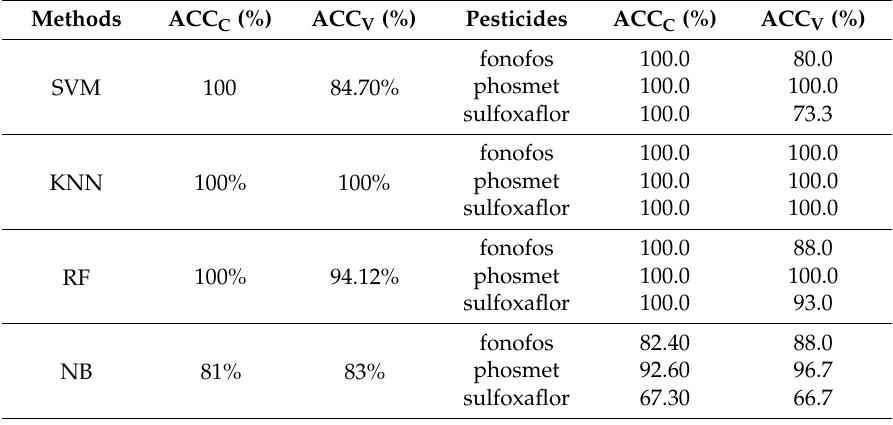
Table 1. Classified results of pesticides in paddy water using different methods.